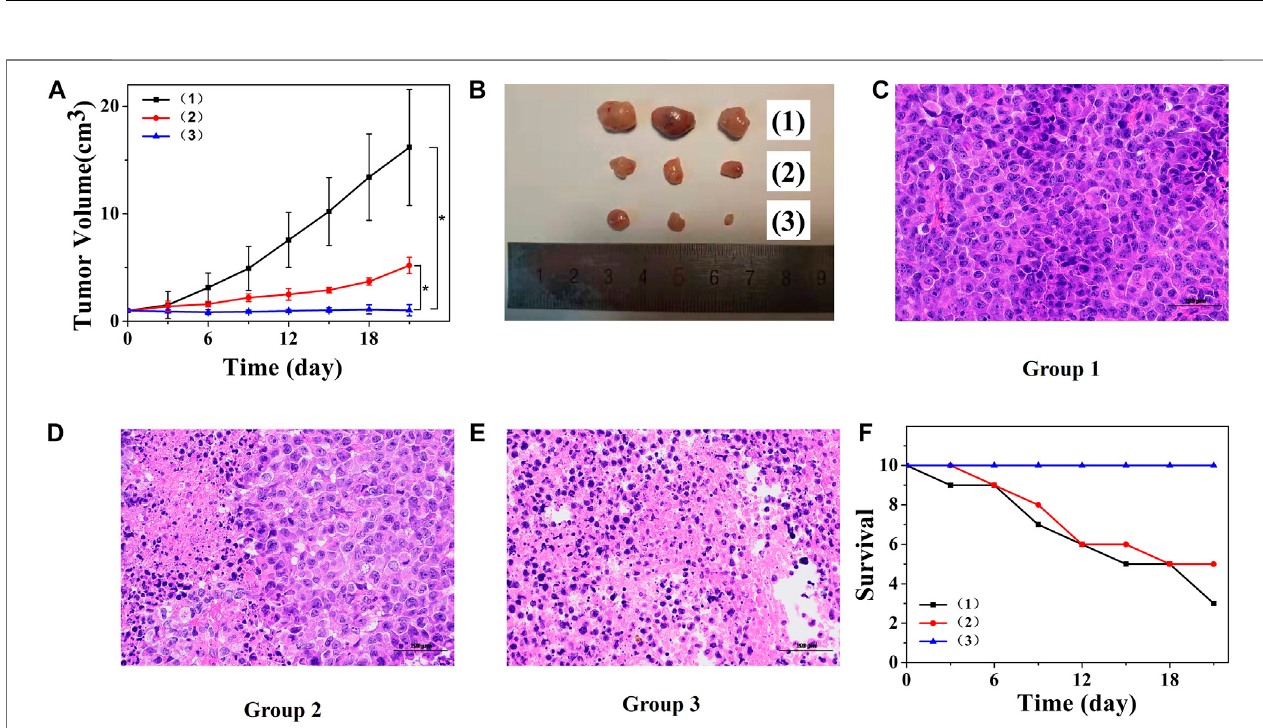
FIGURE 5 | (A) Cytotoxicity pro fi les of 4T1 cells. (B) In vitro cell proliferation-inhibiting ef fi ciency of PTX@PPD NPs and PTX@PSA NPs on 4T1 cells.